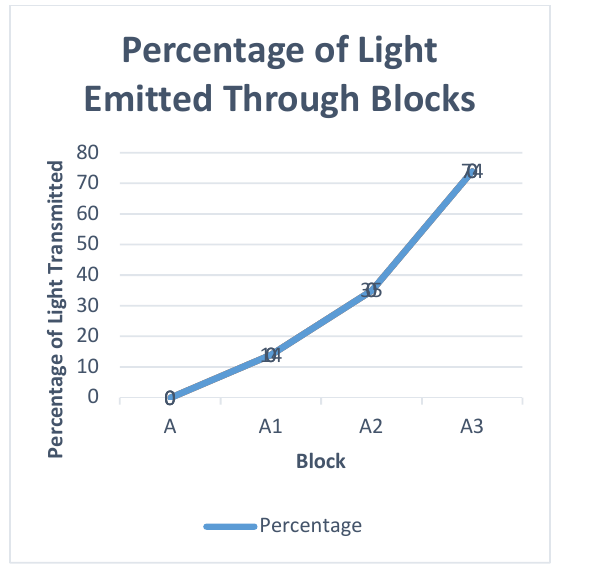
Fig. 21: Average Amount of light Transmitted through each Block